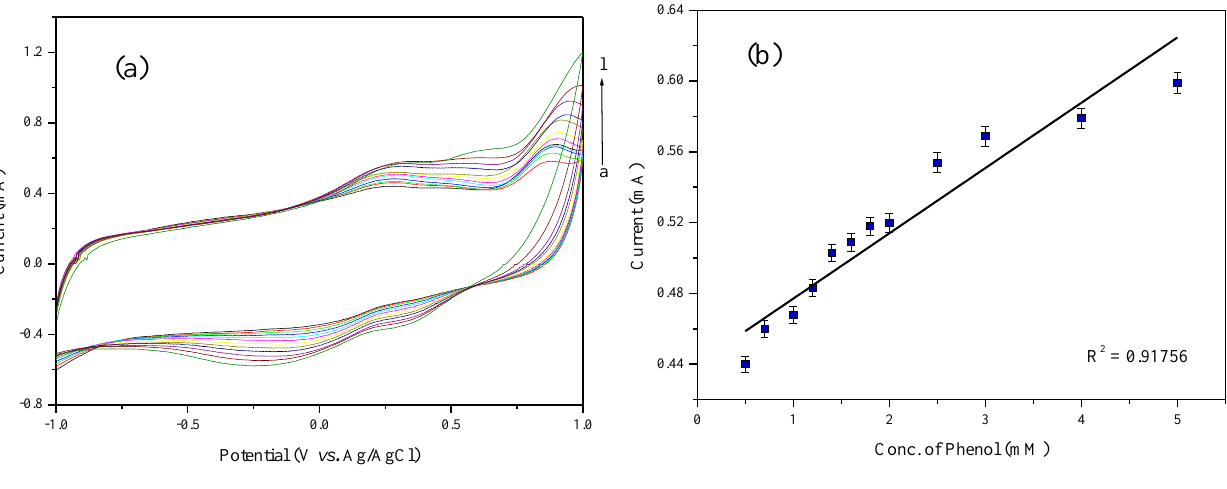
S-MWNT for phenol 2